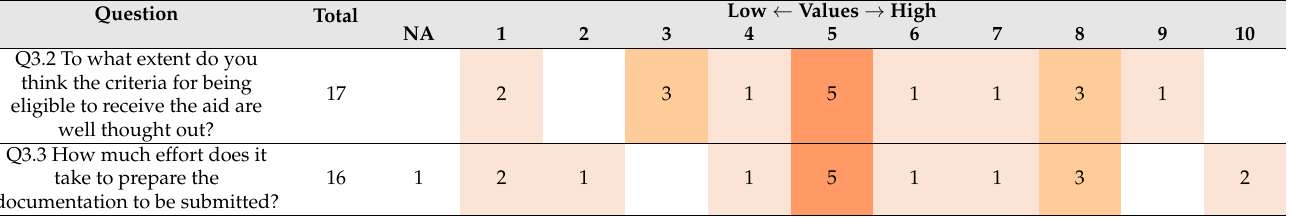
Table 4. Section 3 of the questionnaire—number of responses obtained for each value category.